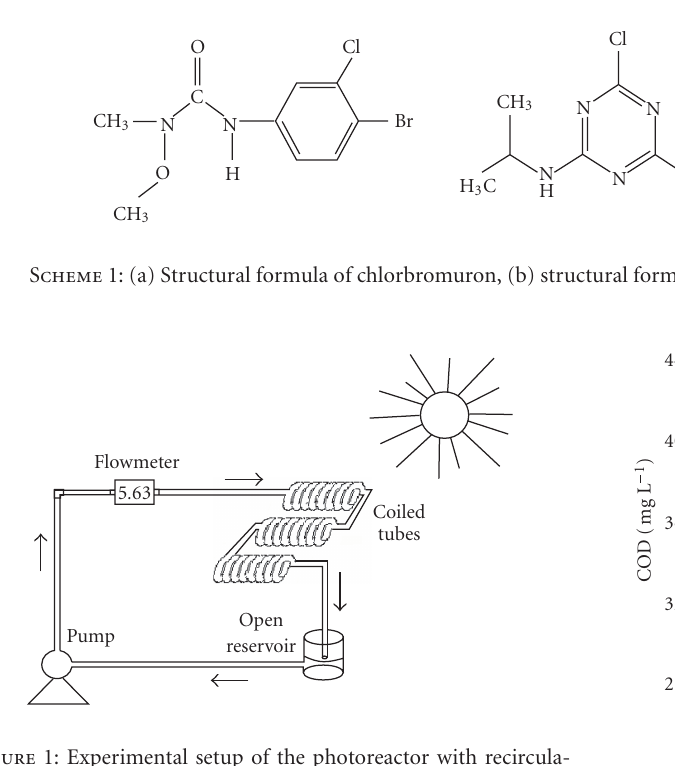
Figure 1: Experimental setup of the photoreactor with recircula- tion.